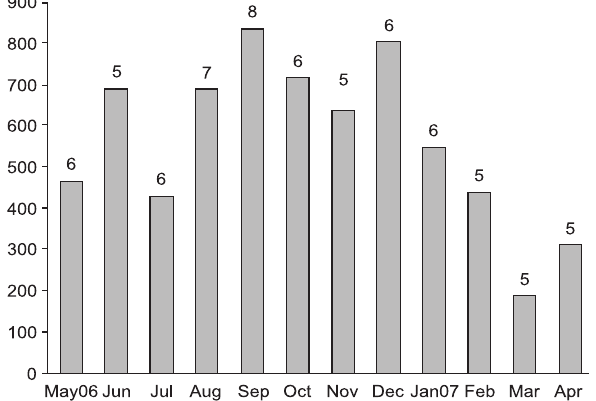
Figure 3. The number of decapod species (above each bar) and individuals (Y axis) captured each month from the Guajará Bay, Pará, Brazil, from May 2006 to April